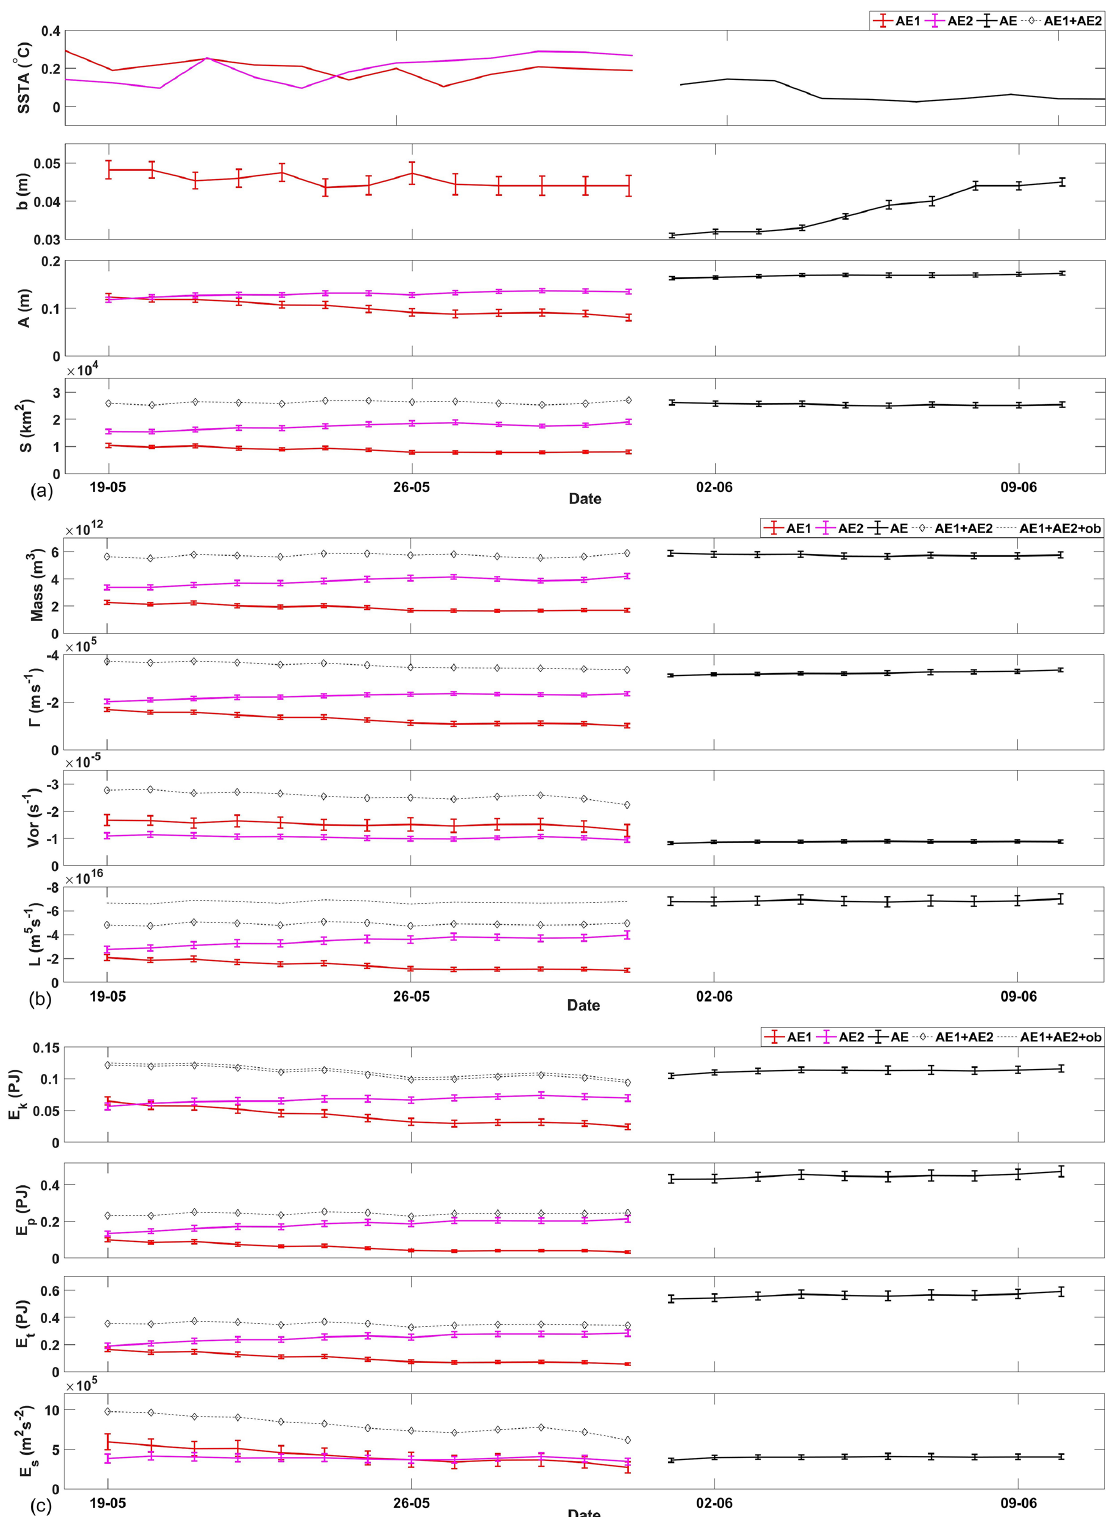
Figure 3. The parameters in the merging event of the surface mesoscale eddies, where “AE1”, “AE2”, and “AE” represent the eddies, respectively, and “ob” represents the orbital AM associated with co-rotation. The error bars indicate the standard deviation of the value. (a) SSTA, background parameter, eddy amplitude, and eddy area; (b) mass, circulation, vorticity, and angular momentum; and (c) EKE, EPE, total mechanical energy, and